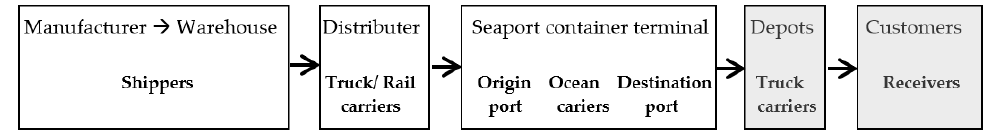
Figure 1. The typical supply chain for containerized cargo .